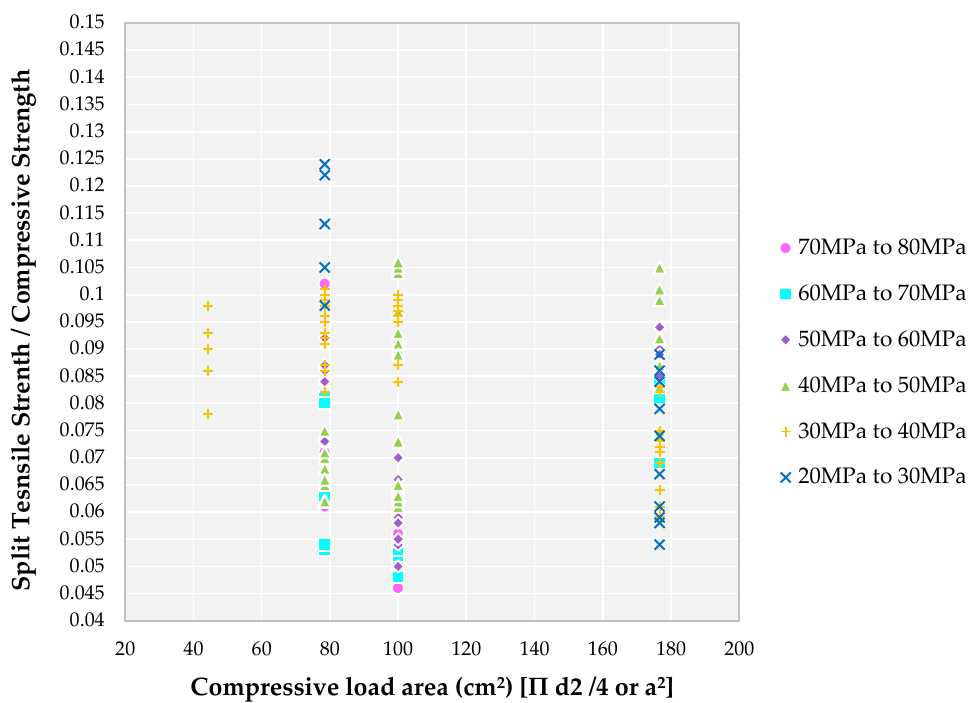
Figure 13. Impact of compressive load area on various compressive strength of SCC concrete with recycled aggregate according to literature.